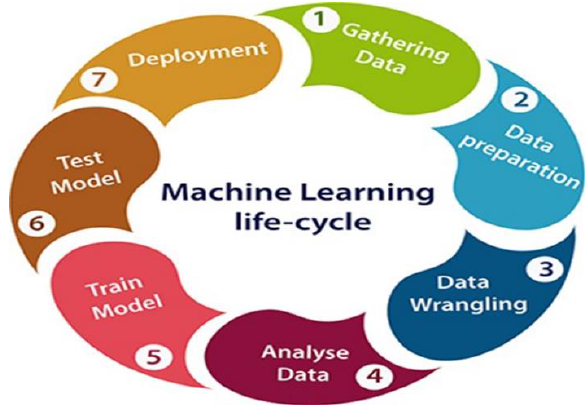
Figure 3. Life Cycle of Machine Learning.